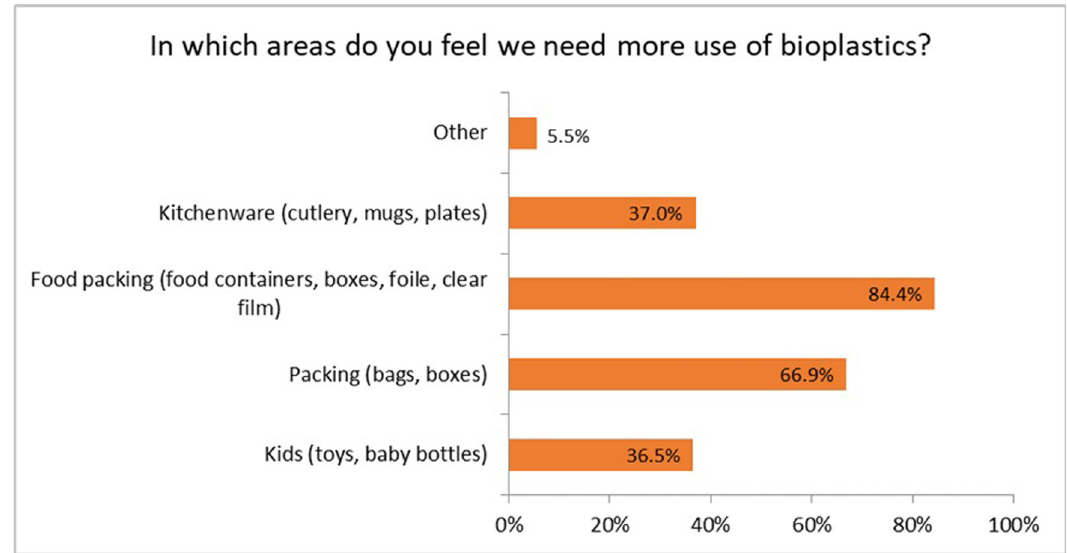
Fig 8. Likelihood of increasing application areas of bioplastics (n =